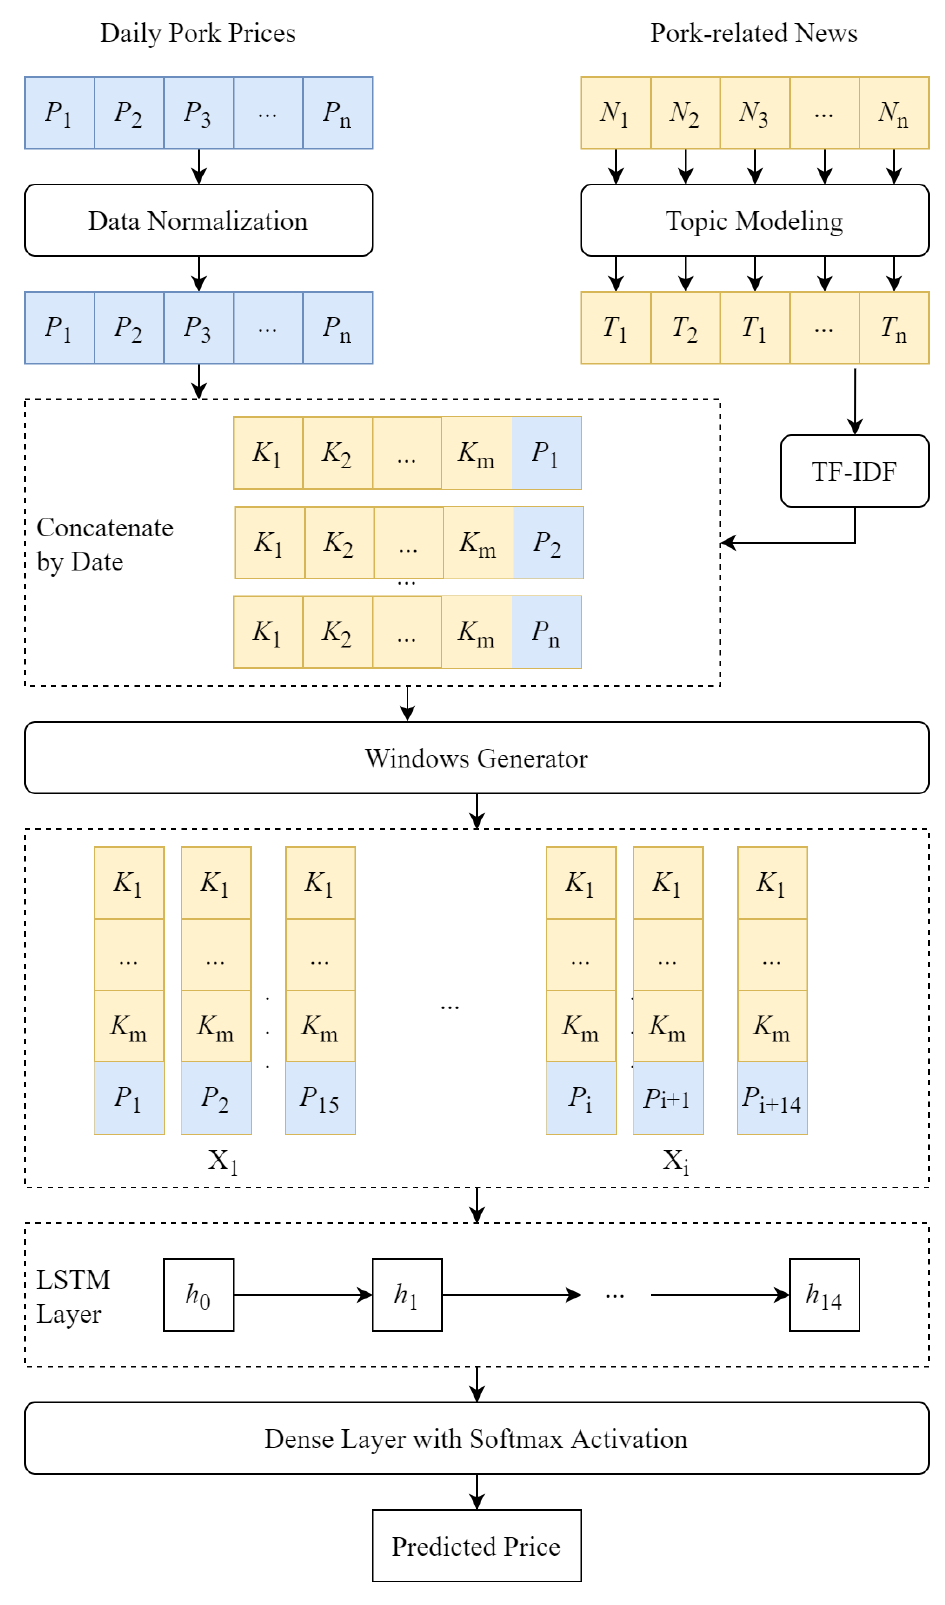
Figure 5. Overview of price predictions with long short-term memory (LSTM).